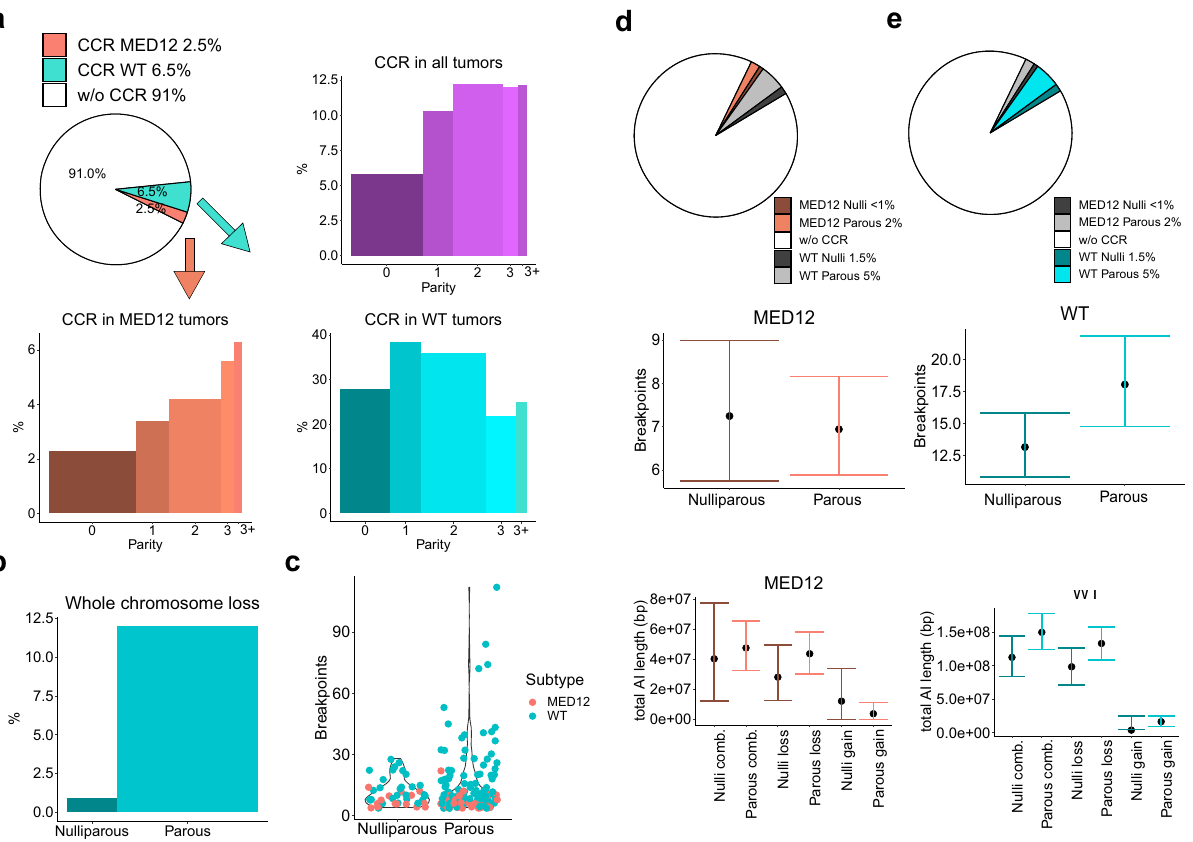
Fig. 3 Overview of complex chromosomal rearrangements (CCRs). a Summary of CCR statuses for all 1935 tumors (purple), strati fi ed by patient ’ s parity. Similarly, CCR statuses among MED12 mutated tumors (salmon) and among WT tumors (turquoise). b Association between whole chromosome loss and parity. c , Breakpoint number in tumors with CCR, strati fi ed by nulliparous ( n = 45 tumors) and parous patients ( n = 134 tumors). Orange dots depict MED12 mutated tumors, turquoise WT tumors. Of note, all ULs with a high breakpoint number are from parous patients ’ WT tumors. The mean number of breakpoints in CCR – nulliparous tumors is 13.0 (95% CI: 10.93 – 15.79) and in CCR – parous tumors 18.17 (14.74 – 22.14). d , An average breakpoint number, total length of loss regions, total length of gain regions and the combined length of loss and gain regions are presented for MED12 tumors with CCR ( n = 52) from parous ( n = 36) and nulliparous patients ( n = 16). 95% bootstrap con fi dence intervals are presented for the mean. e An average breakpoint number, total length of loss regions, total length of gain regions and the combined length of loss and gain regions are presented for WT CCR tumors (n = 127) from parous ( n = 98) and nulliparous patients ( n = 29). 95% bootstrap con fi dence intervals are presented for the mean. Source data are